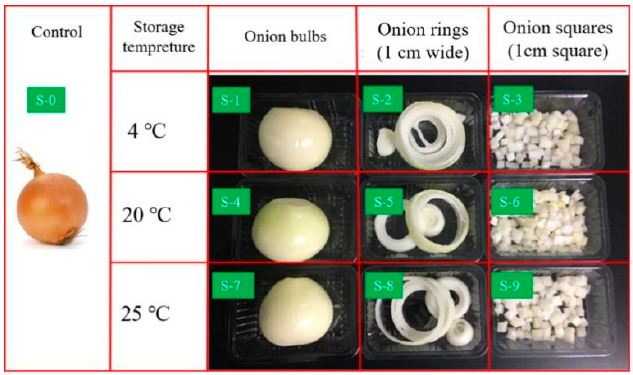
Figure 1. Appearance of samples. Labels: “ S − 0 ” represents the untreated onion (control group); “ S − 1 ” , “ S − 2 ” , and “ S − 3 ” represent the onion bulbs, onion rings, and onion squares stored at 4 ° C; “ S − 4 ” , “ S − 5 ” , and “ S − 6 ” represent the onion bulbs, onion rings, and onion squares stored at 20 ° C; “ S − 7 ” , “ S − 8 ” , and “ S − 9 ” represent the onion bulbs onion rings, and onion squares stored at 25 ° C.